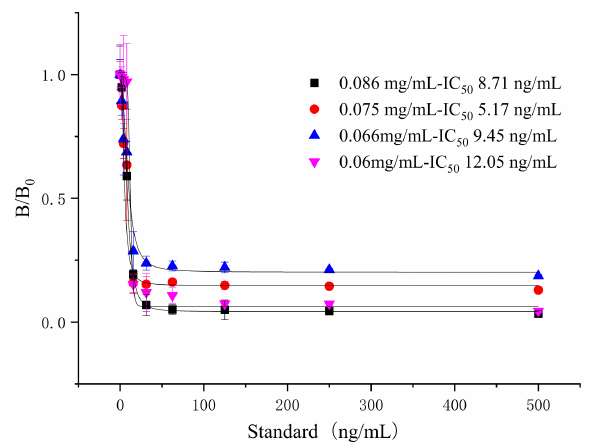
Figure 7. Dosage selection of the goat anti-mouse IgG for tylosin ( n = 3).